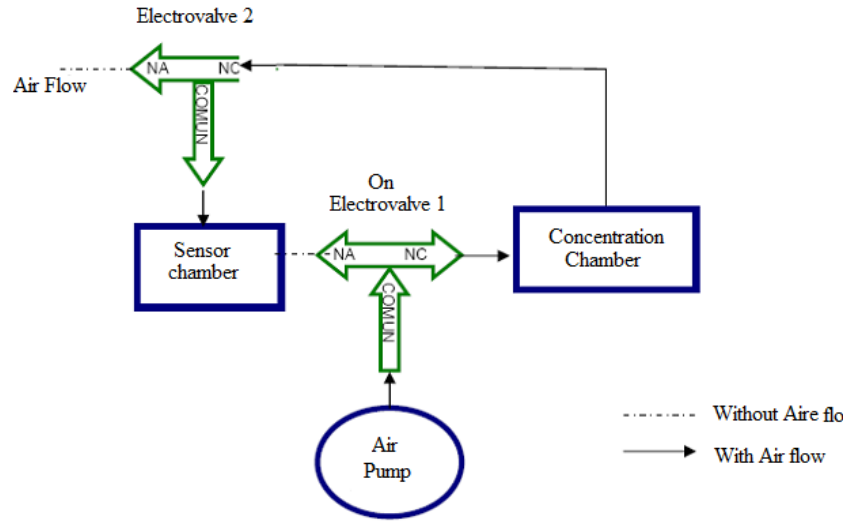
Figure 3. Diagram of air flow in the stage of Measure.